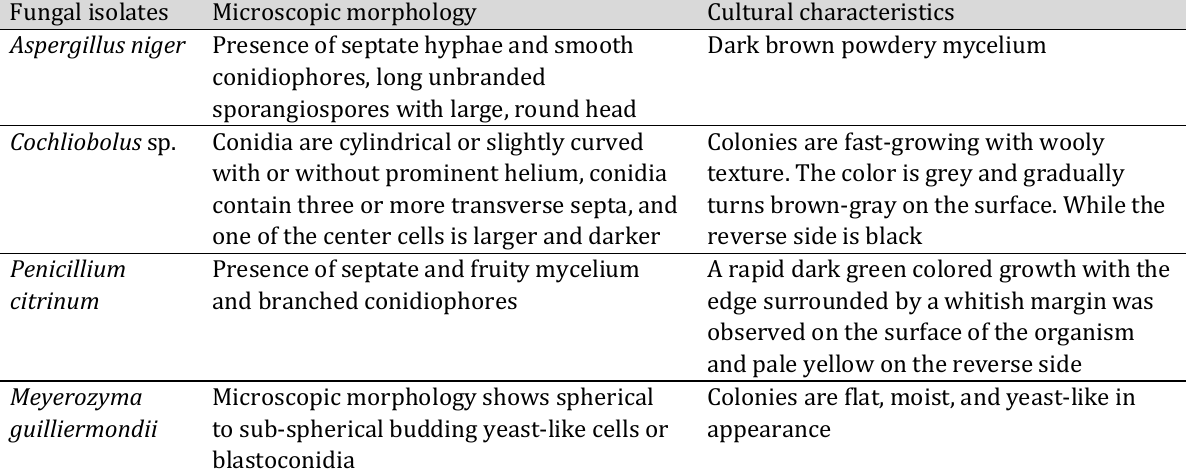
Table 6. Morphological characteristics of fungi isolated from the treated raw palm oil.